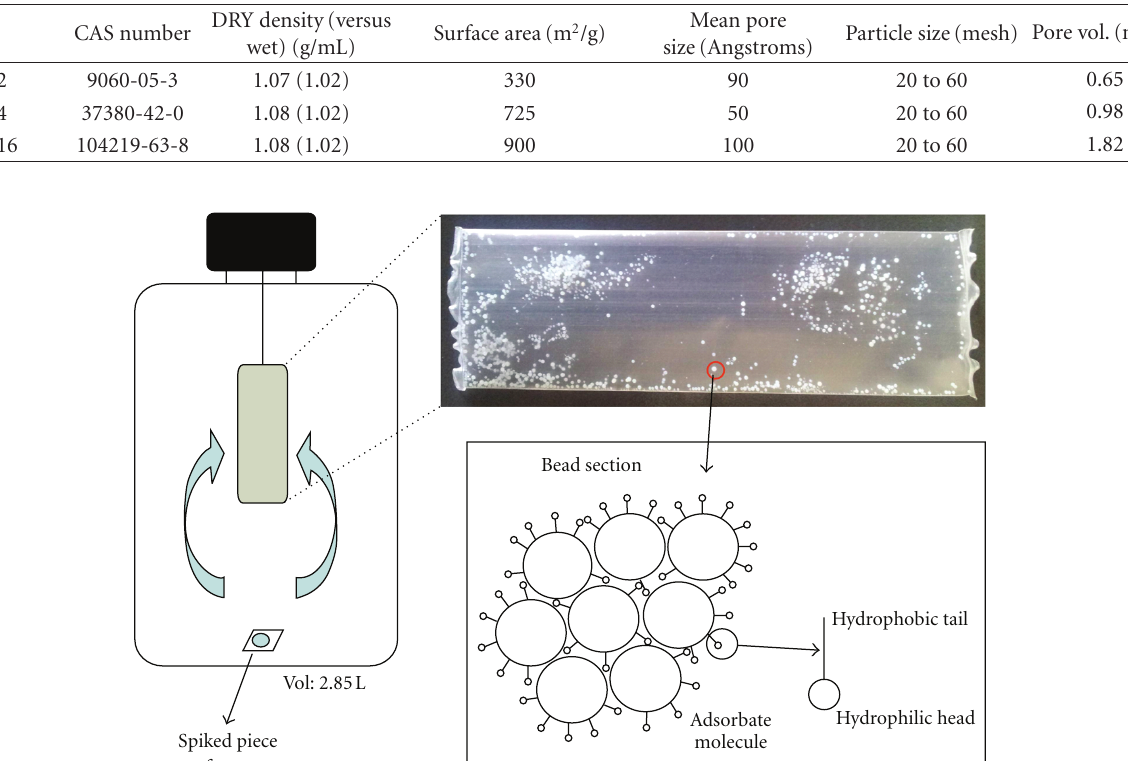
Figure 1: Diagram of the sampler and sampling process. Inset: structure of an Amberlite XAD-2 resin